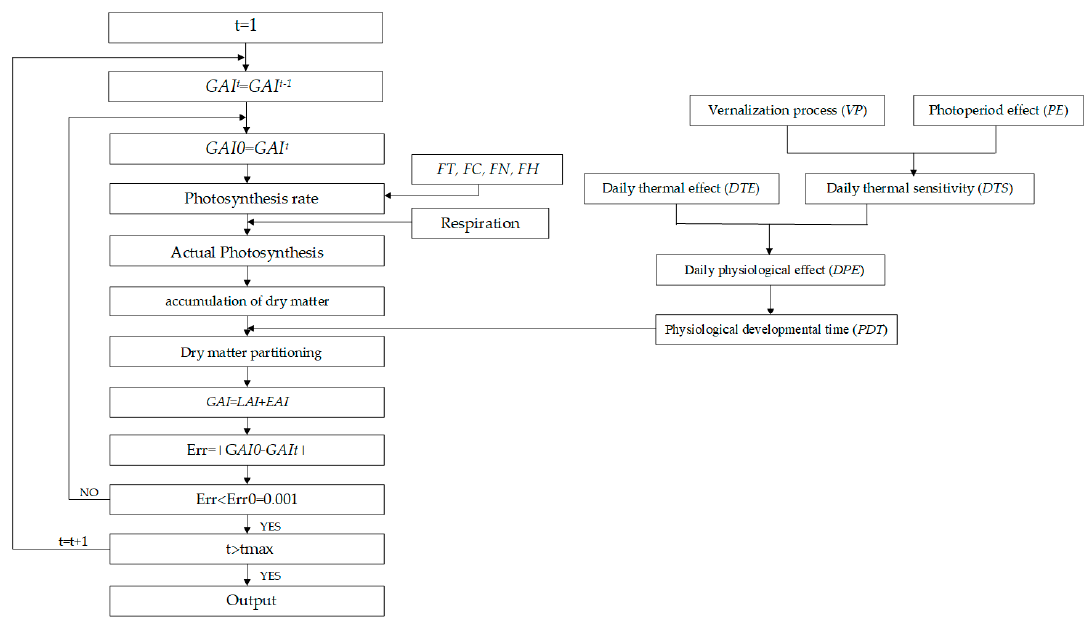
Figure 3. Calculation flowchart of the crop module. The EAI is the ear area index; FT , FC , FN , and FH are the temperature influence factor, CO 2 concentration influence factor, nitrogen influence factor, and water influence factor, respectively.